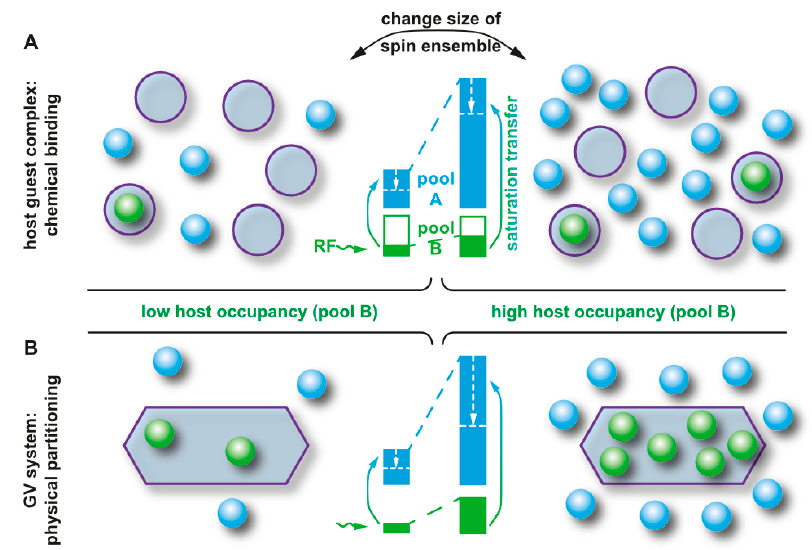
Figure 13. Self-adjusting filling of Xe hosts. ( A ) Chemical affinity of Xe to CrA: The number of loaded hosts does not scale linearly with increasing the total amount of Xe in the solution. ( B ) Physical partitioning into the GV cavity: The GVs are “elastically” loaded with a number of Xe atoms that reflects the size of the dissolved Xe pool according to Henry’s law. Reprinted with permission from Kunth et al. ACS Nano 2018, 12, 10939–10948 [133]. Copyright (2018) American Chemical Society.